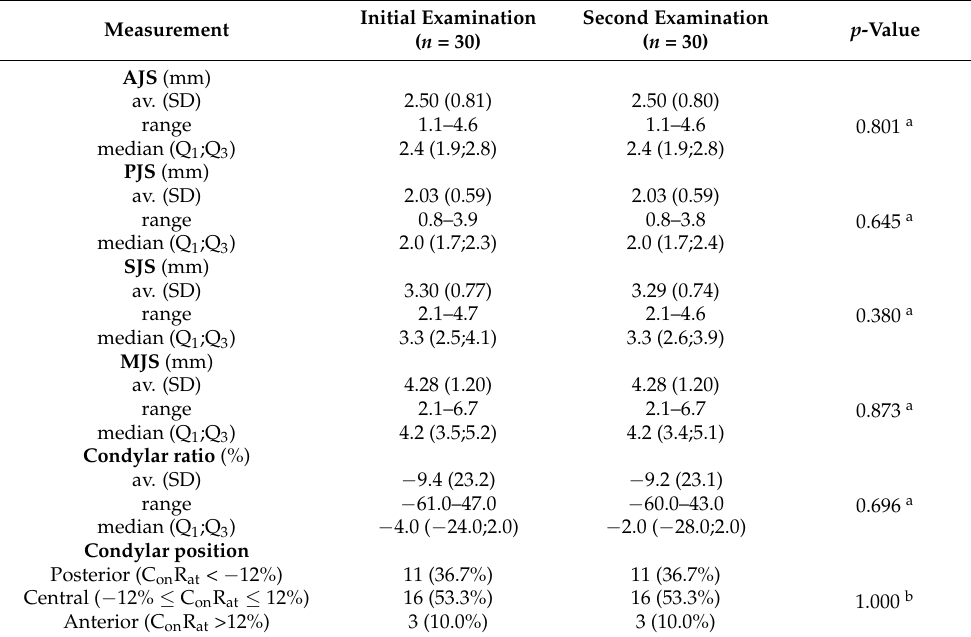
Table 6. The average values of different joint spaces and condylar ratio during initial and second examination in the control group.